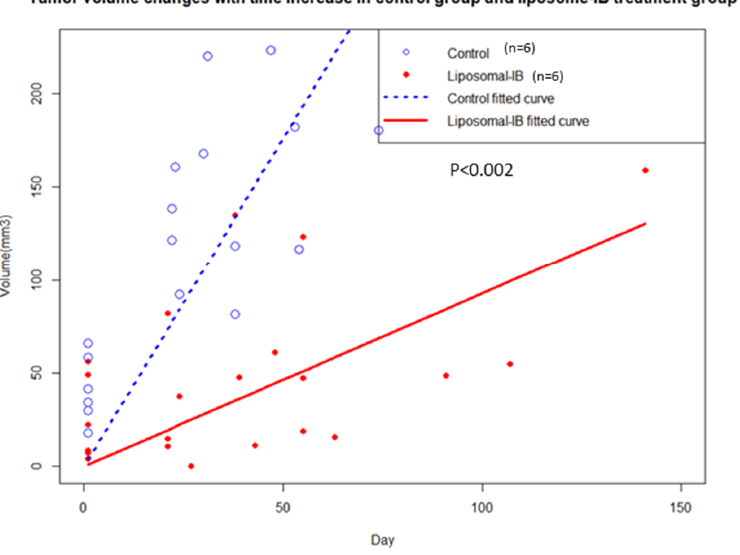
Figure 4. Tumor volume comparison between control and Lipo-IB treated mice for all the mice tested. Blue hollow circles (O) represent mice from control group and the red solid circles represent mice from the treatment group.